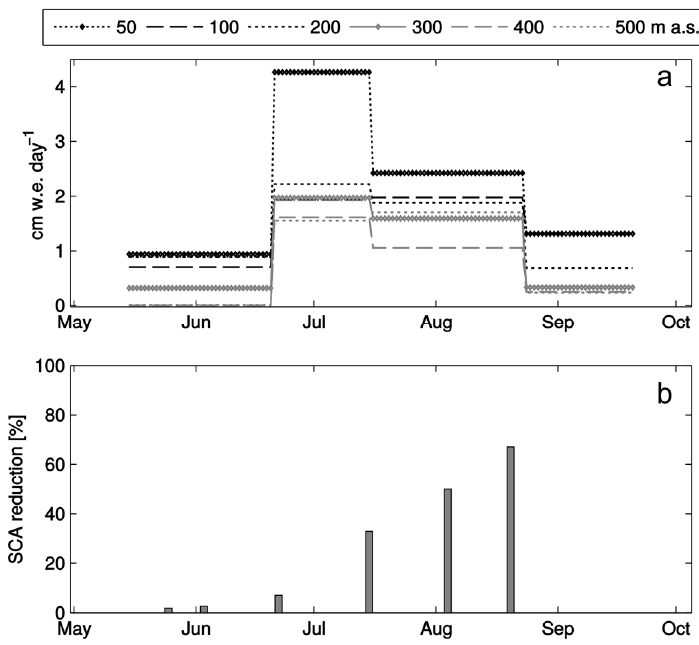
Figure 3. Variability of the surface melt rate based on mass-balance stake data ( a ) and Snow-Covered Area reduction based on Landsat 8 images ( b ) on Hansbreen in the melting period of 2014.